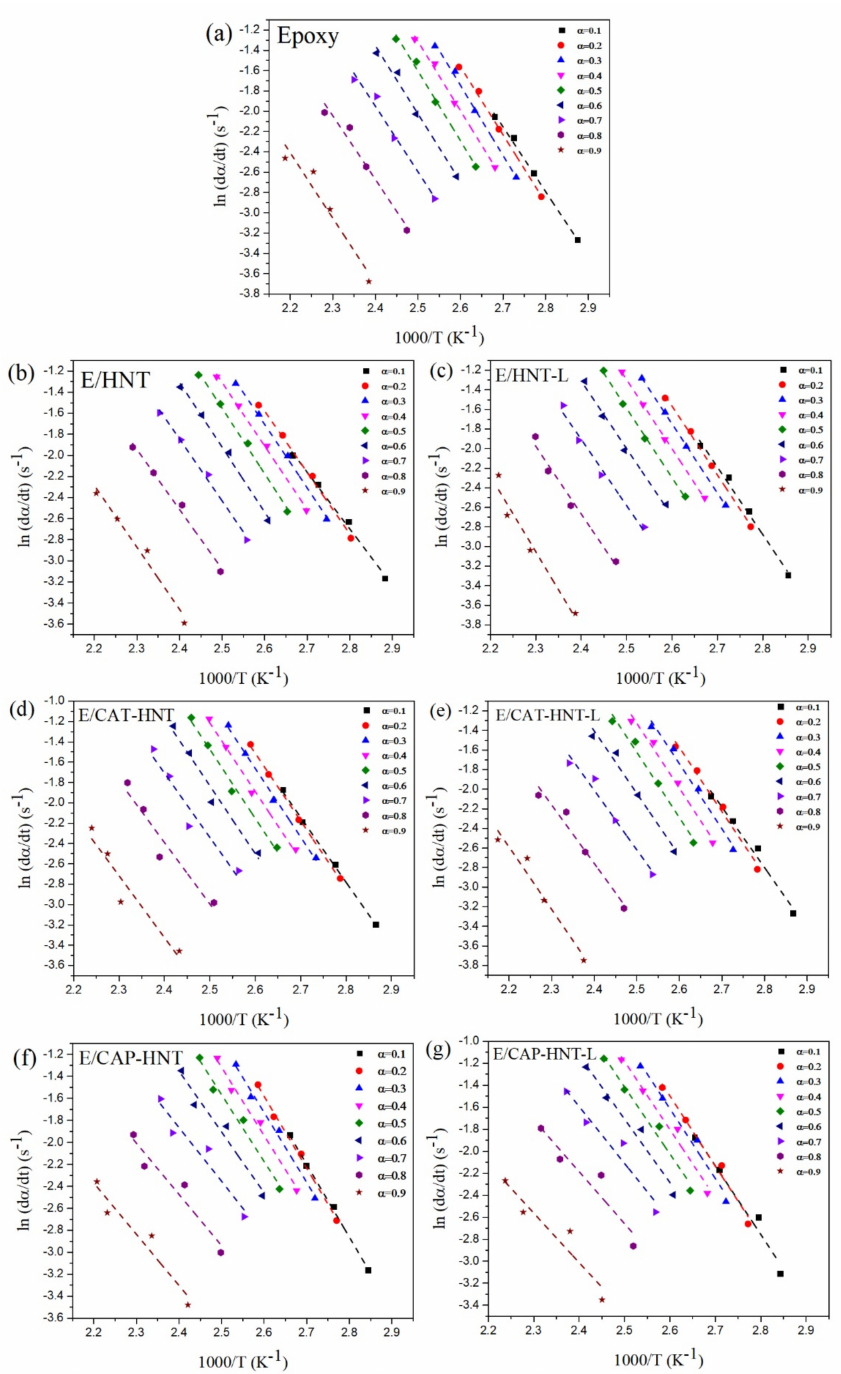
Figure A2. ( a – g ) Plots of the prepared samples based on Friedman model at β = 5 ◦